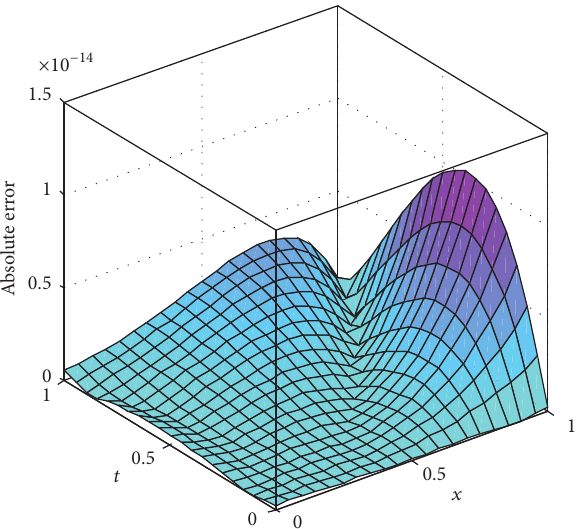
Figure 9: The absolute error for Example 3 with 𝑚 = 7 .